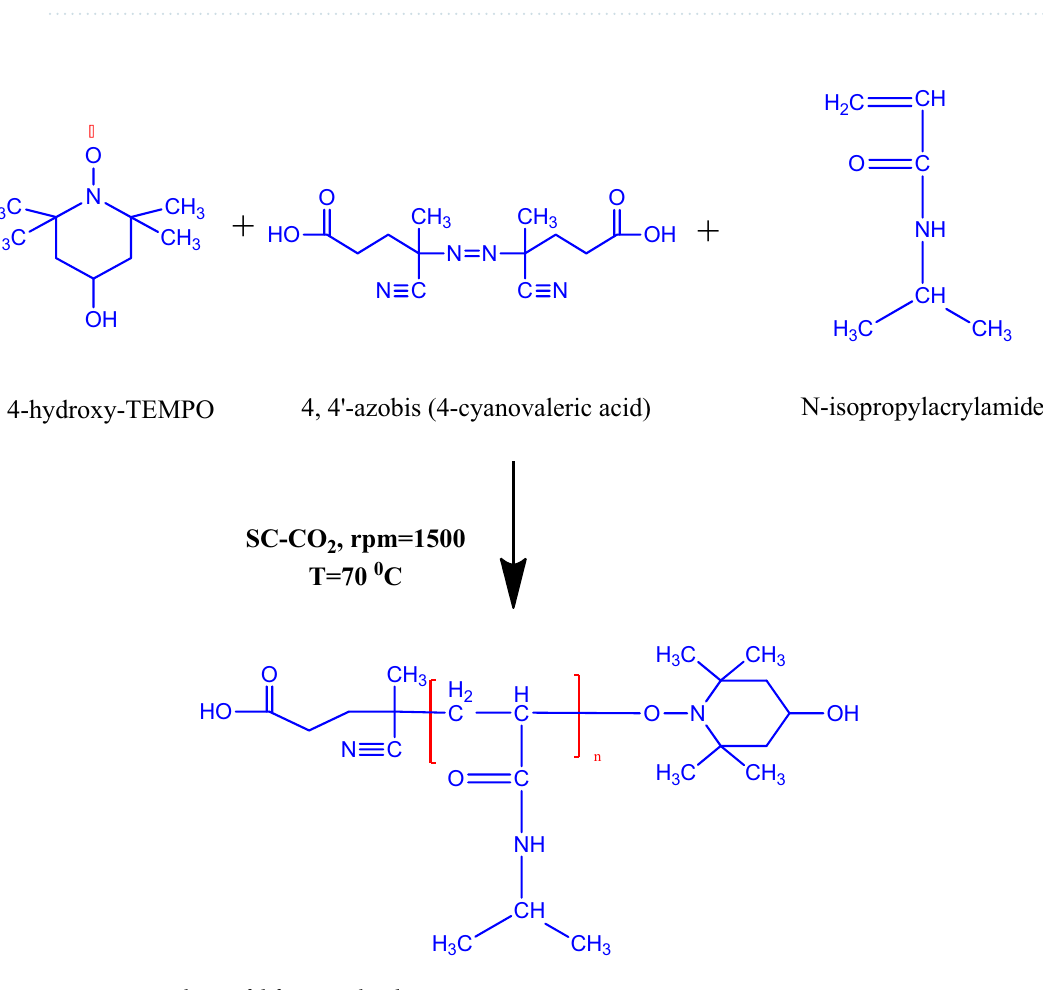
Figure 2. Synthesis of difunctionalized PNIPAAM in SC-CO 2